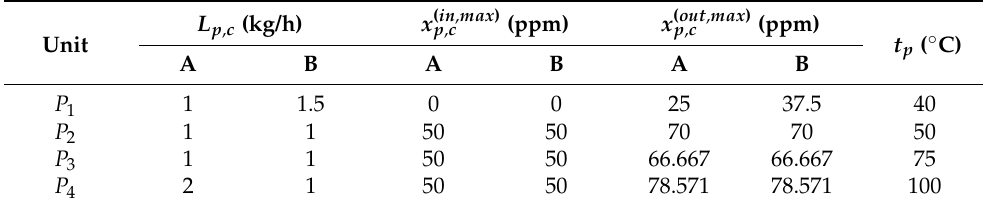
Table 4. Process water-using units data for Example 2.